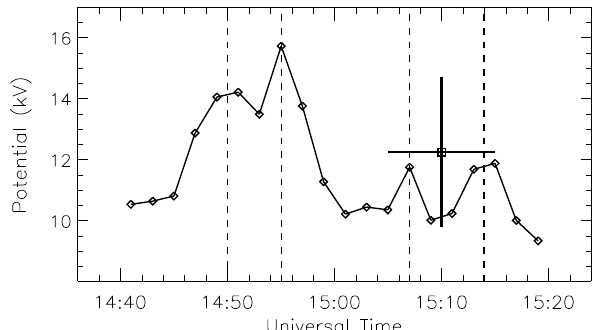
Fig. 10. The temporal variation of the reconnection potential (solid line and diamonds). The square with the bold error bars represents the potential measured between the centres of the reverse convec- tion cells during a DMSP-F13 overpass. The vertical dashed lines highlight transient enhancements in the reconnection potential.